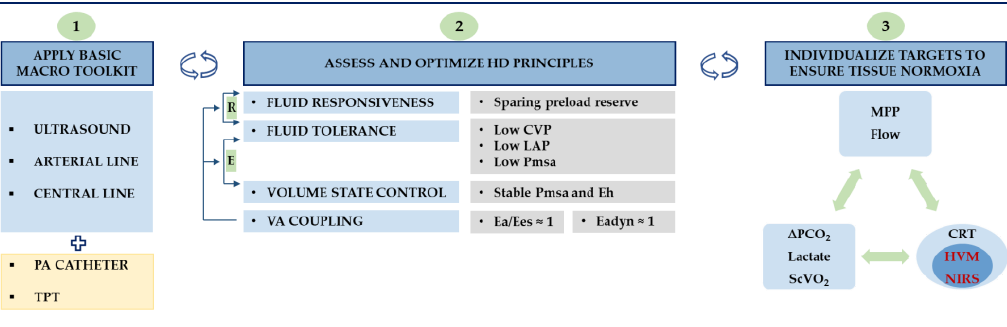
Figure 6. Conceptualized approach to shock management. Panel 1: a minimal hemodynamic toolkit is presented, encompassing ultrasound, arterial and central venous lines. Extended monitoring comprises pulmonary artery (PA) catheter and transpulmonary thermodilution (TPT). Panel 2: during active resuscitation (R), fluid responsiveness and fluid tolerance need simultaneous assessment, ensuring that: (1) preload reserve is spared, and (2) the minimum increase in intravascular pressures required to sustain adequate tissue perfusion is targeted to guard fluid tolerance. As a corollary, deterioration of fluid tolerance is poised to hamper tissue perfusion and hence requires resolution. During evacuation (E), fluid tolerance and volume state control need simultaneous assessment, ensuring that fluid removal rate is tuned to reach efficiency (lower CVP) and tolerance (preserved CO and MAP). Overall, stable Pmsa and Eh guarantee hemodynamic stability during evacuation phases. In preload independent states, higher removal rates and lower Pmsa can be achieved safely until a threshold is reached when further decreasing Pmsa would result in impaired Eh and low CO. VA coupling represents an energetic refinement of the cardiovascular state that may be superimposed regardless of phase. For practical reasons, Ea/Ees and Eadyn are set to 1 (See Tables A1 and A2 for further discussion). Panel 3: An integrative approach encompassing macro- and microvascular targets is schematized, emphasizing that target individualization is paramount to improving outcomes. From a microcirculatory perspective, bedside clinicians must rely on clinical examination (i.e., CRT) until more objective monitoring (i.e., HVM) becomes available. CO, cardiac output; CRT, capillary refill time; CVP, central venous pressure; Ea, arterial elastance; Eadyn, dynamic arterial elastance; Ees, ventricular elastance; Eh, global heart efficiency; HVM, handheld vital microscope; LAP, left atrial pressure; MAP, mean arterial pressure; MPP, mean perfusion pressure; NIRS, near-infrared spectroscopy; Pmsa, mean systemic filling pressure analogue; ScVO2, central venous oxygen saturation; VA, ventriculoarterial; ∆ PCO2, venous-to-arterial carbon dioxide partial pressure